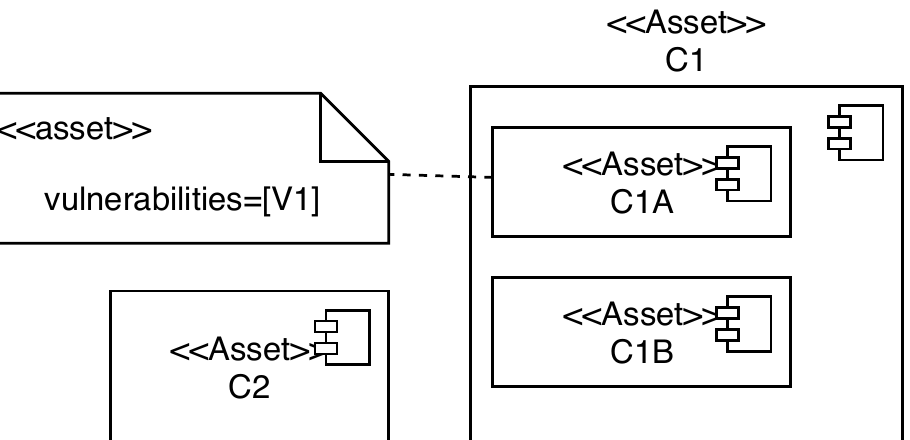
Figure 10. The structural